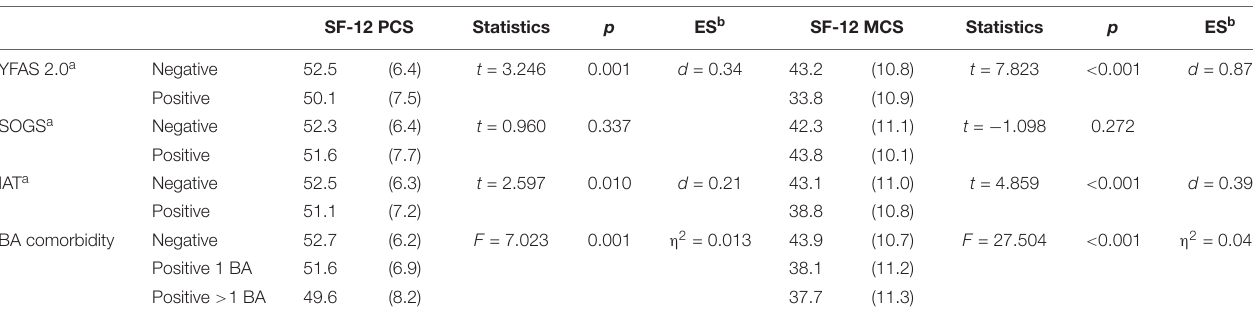
TABLE 3 | Comparison between behavioral addictions and SF-12 dimensions. SF-12 PCS